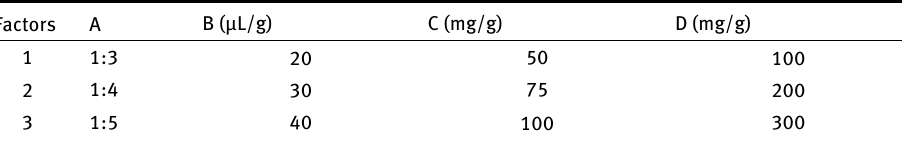
Table 1: Factors and levels of orthogonal experiment